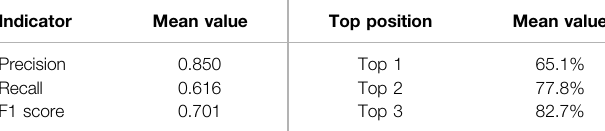
TABLE 3 | Classifying power and ranking power of AutoGluon models on the test